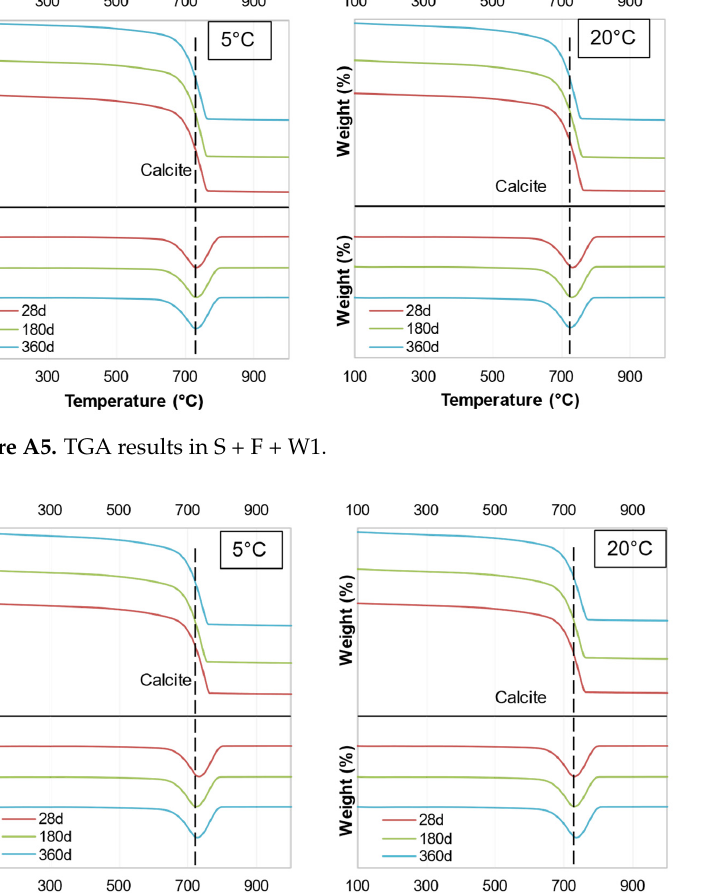
Figure A7. TGA results of S + C + W1. Figure A8. TGA results of S + C + W3.